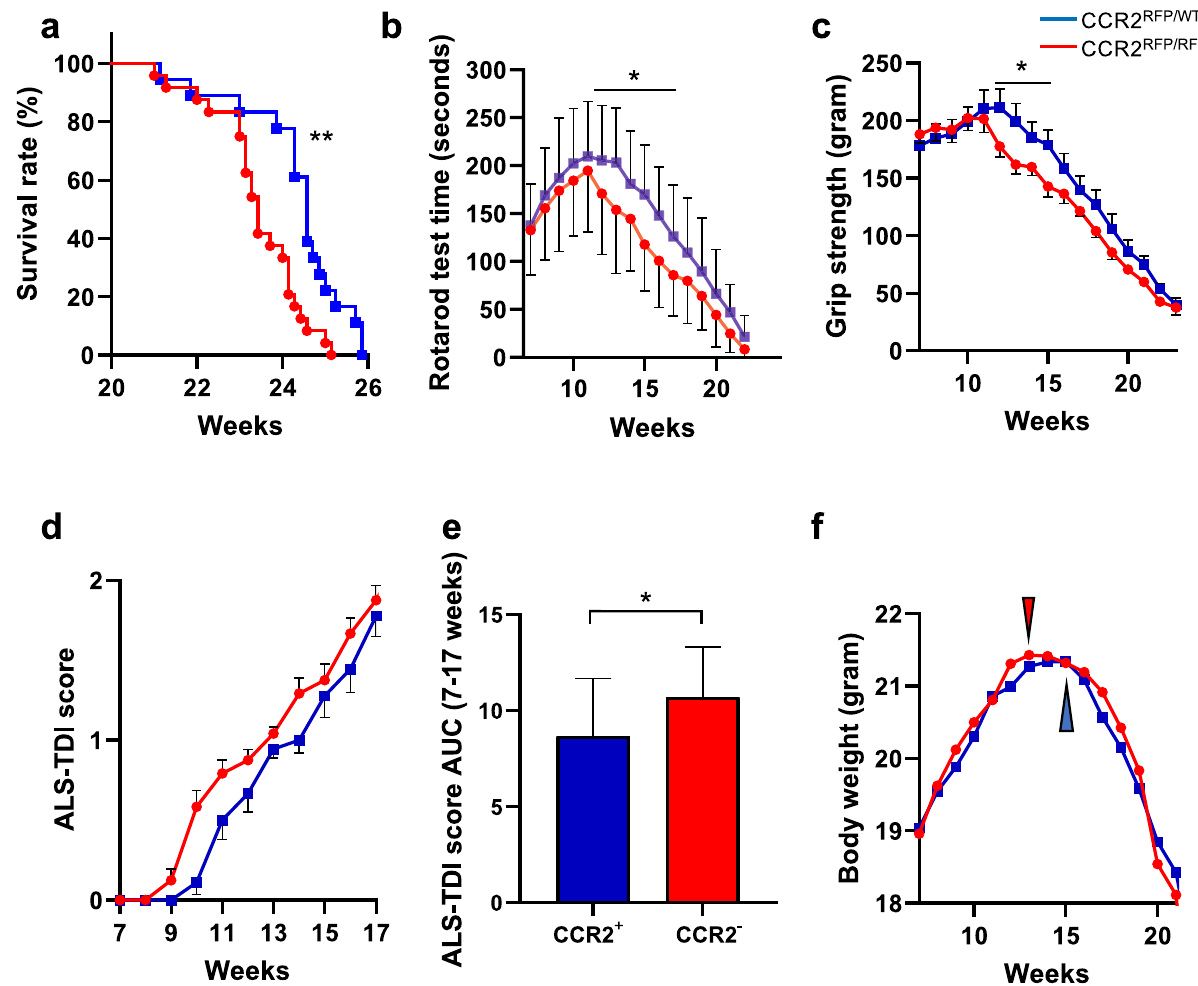
Figure 3. Clinical manifestations of CCR2-positive and CCR2-deficient SOD1 G93A mice. ( a ) Median survival time, ( b ) rotarod test, ( c ) grip strength, ( d ) ALS-TDI score, and ( e ) area under the curve (AUC) of ALS-TDI scores measured from 7 to 17 weeks of age in ( d ). ( f ) Mean age of disease onset was defined as when mice reached peak body weight (CCR2-positive SOD1 G93A mice, n = 24, and CCR2-deficient SOD1 G93A mice, n = 18). The log-rank test was used to compare median survival time and onset time by body weight. Student’s t test was used for statistical comparisons of rotarod test and grip strength. The Mann–Whitney U -test was used